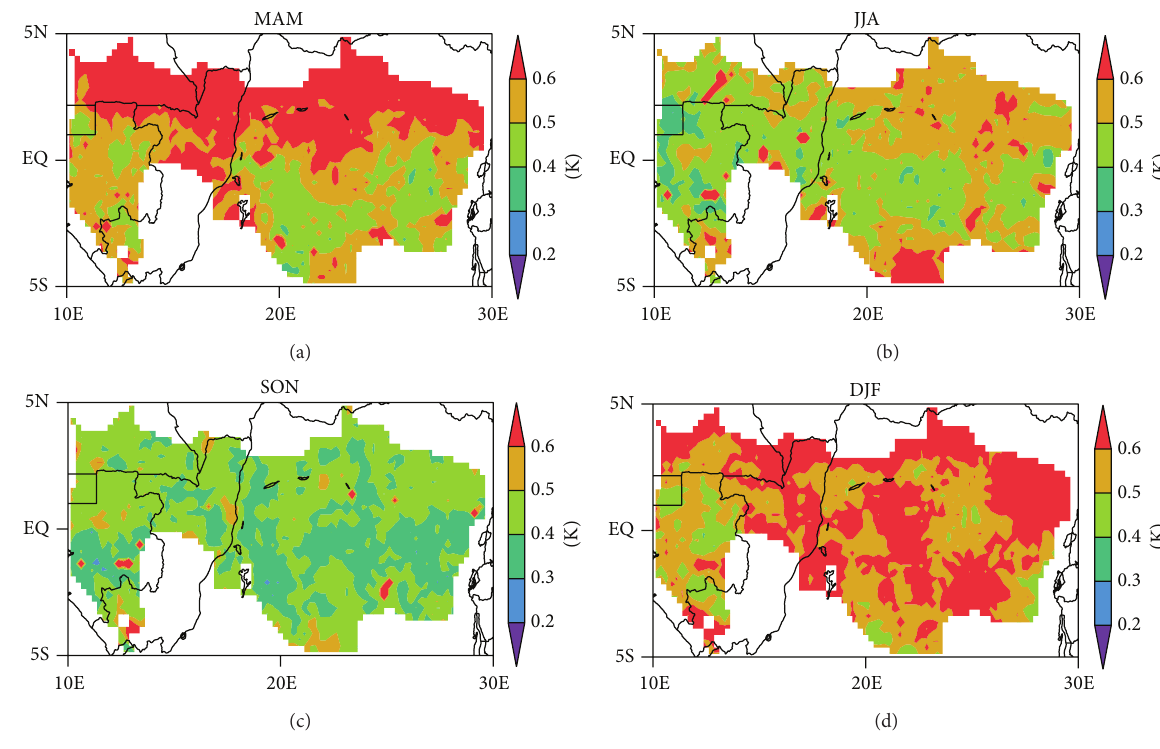
Figure 9: The same as Figure 8 but at 6:30